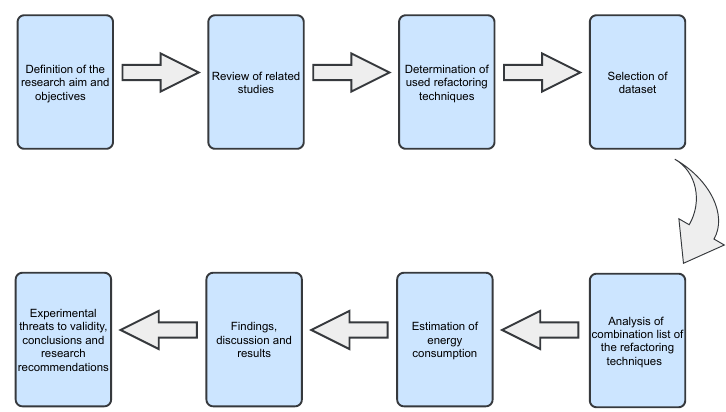
Figure 1. Summary flowchart for the structure of the